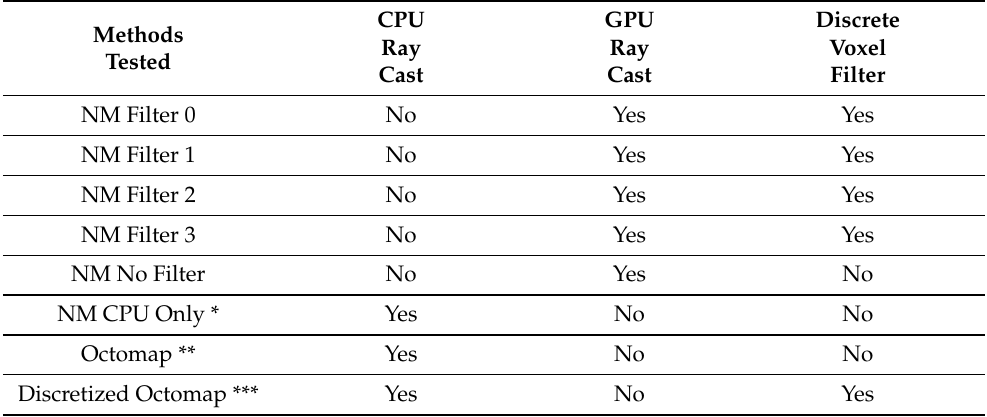
Table 2. Key features of evaluated methods.